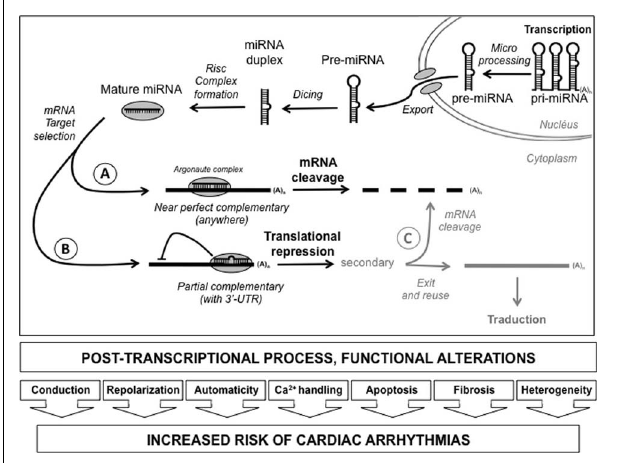
FIGURE 2 | Diagram depicting post-transcriptional process by miRNA. After their transcription, the pri-miRNA were matured in pre-miRNA and exported to cytoplasm. After digestion by dicer and Risc complex formation, the mRNA target selection can take place depending on the quality of the match. When the complementary is near perfect, throughout the length of the mRNA, cleavage of the messenger will take place leading to its degradation (A) . However, if the setting is only partial, usually in the 3 (cid:3) -untranslated region, a translational repression can take place without any degradation on the messenger (B) . Secondarily, it is possible for the cell to remove the inhibition and to reuse either definitively destroy the messenger (C) [ 3 (cid:3) -UTR : 3 (cid:3) -untranslated region; ( A ) n : polyadenylation